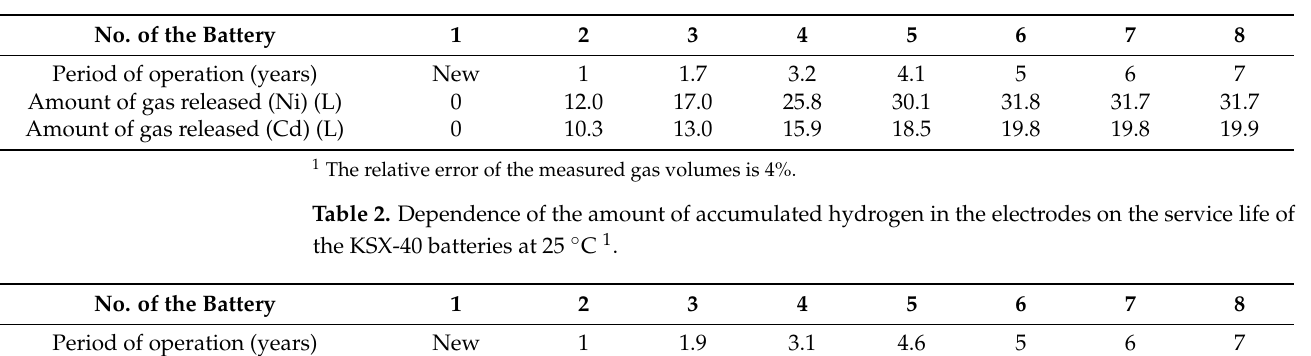
Table 1. Dependence of the amount of accumulated hydrogen in the electrodes on the service life of the KSL-12 batteries at 25 ◦ C 1 .